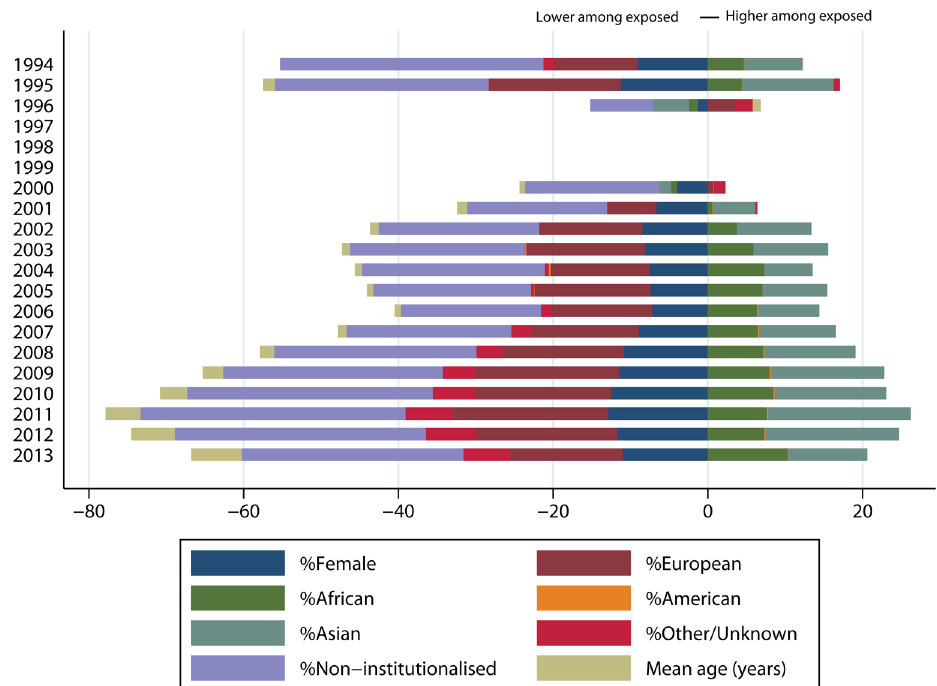
Fig 5. Absolute difference in need variables (exposed minus unexposed group). Y-axis: shows percentage-point differences between groups with restricted access (exposed) and regular access (unexposed) to health care for all need variables, except for, “ mean age ” where the difference is in years. The observations in 1997 – 1999 were excluded from the analysis because the group with regular access (on 31 Dec) was zero. The category, “ Other/Unknown ” comprises asylum-seekers with nationalities from Australia and Oceania, stateless asylum-seekers, and asylum-seekers for with unknown